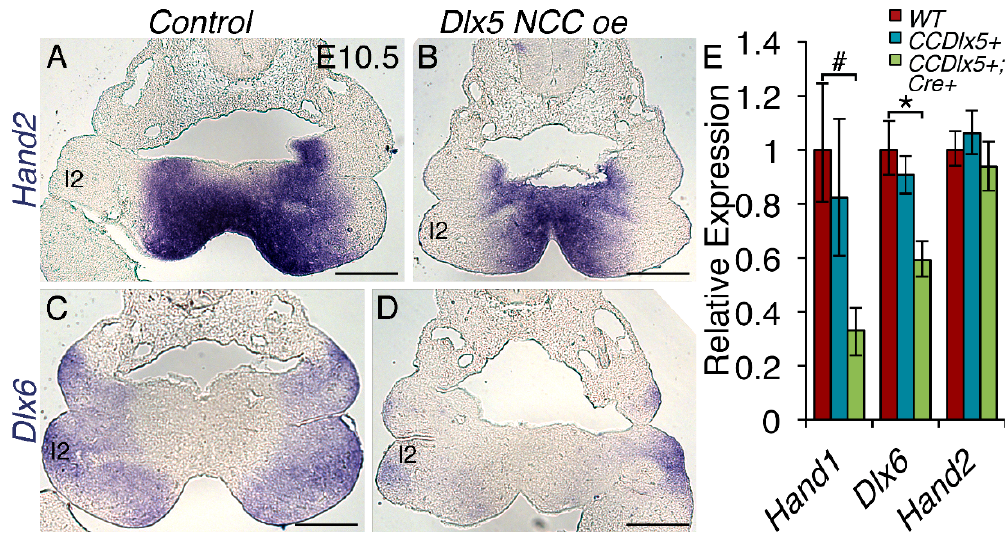
Figure 8. Dlx5 NCC overexpression downregulates Dlx6 within the first pharyngeal arch. ( A , B ) Hand2 in situ hybridization showing normal first arch expression in both control ( A ) and Dlx5 NCC oe E10.5 embryos. Dlx6 in situ hybridization showing altered first arch expression when comparing control ( C ) and Dlx5 NCC oe embryos ( D ). ( E ) qRT-PCR analyses of Hand1 , Dlx6 , and Hand2 expression from E10.5 first pharyngeal arches. Significant decreases in Hand1 (# p ≤ 0.01) and Dlx6 (* p ≤ 0.05) are observed. No significant changes in the Hand2 message are detected. Scale bars = 250 µm.